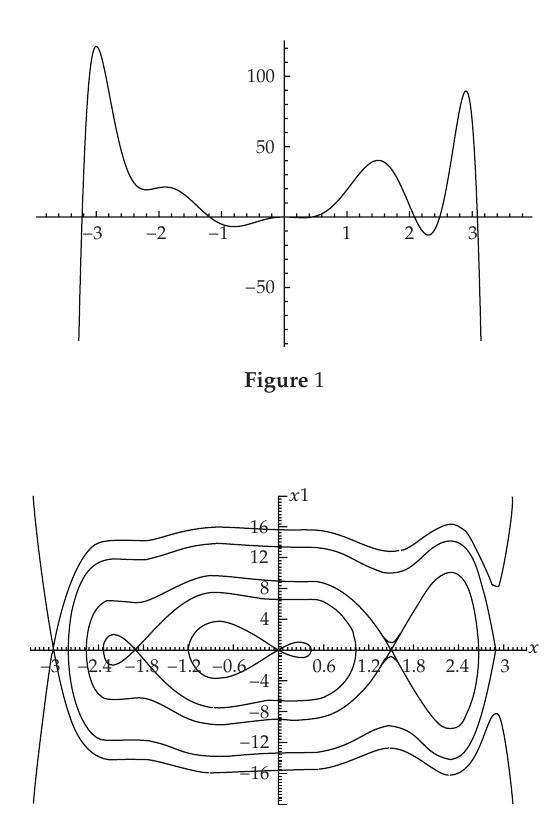
Figure 2: The phase portrait for (cid:3) 1.1 (cid:4) , where G (cid:3) x (cid:4) is as in Figure